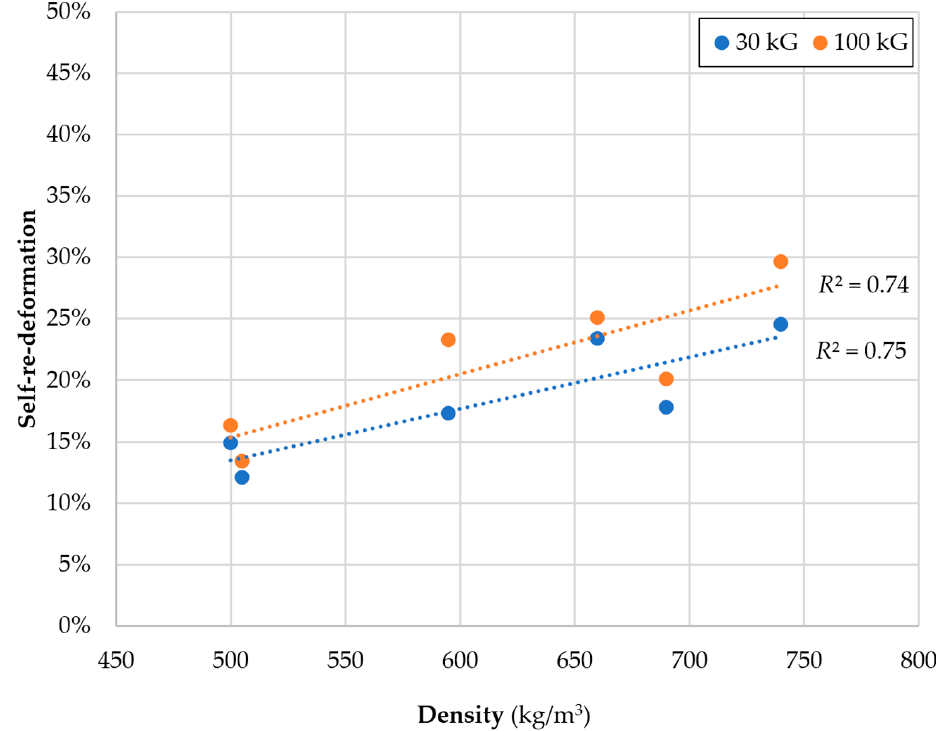
Figure 14. The ability of self-re-deformation in the T cross-section versus wood density.